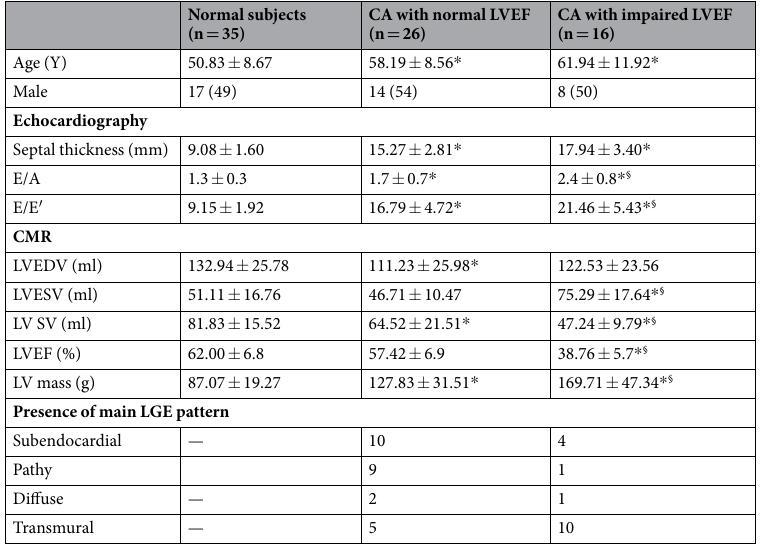
Table 1. Baseline Differences Between Cardiac Normal healthy, AL-CA patients with preserved and impairment LVEF. Notes: The values are the mean ± SD, Numbers in the brackets are percentages. * P < 0.05 versus normal group; § P < 0.05 versus CA with preserved LVEF. AL-CA = light-chain amyloid cardiac amyloidosis; LV = left ventricular; EDV = end diastolic volume; ESV = end systolic volume; EF = ejection fraction; SV = stroke volume; LGE = Late gadolinium